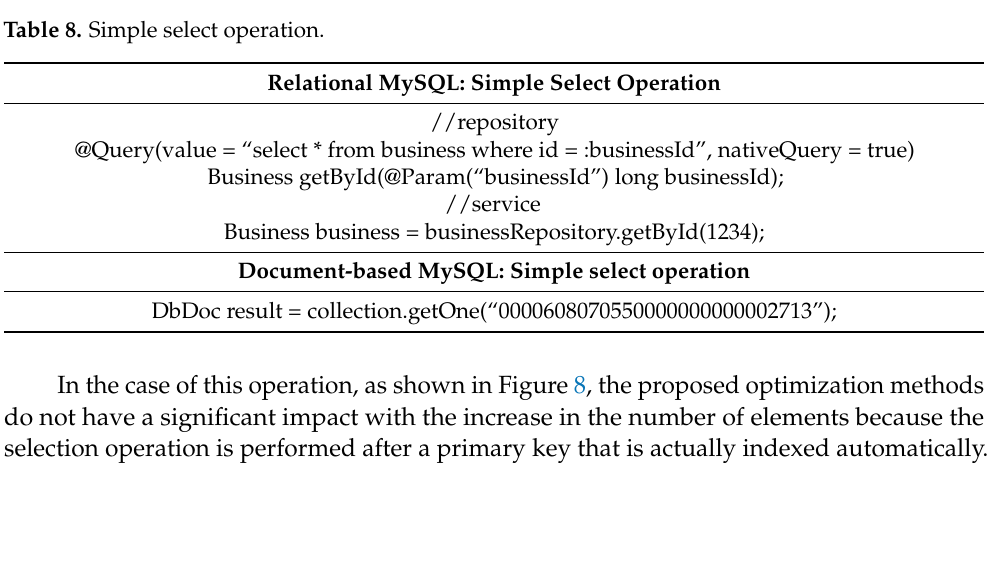
Figure 7. Performance time (ms) for the update multiple elements and multiple fields operation.